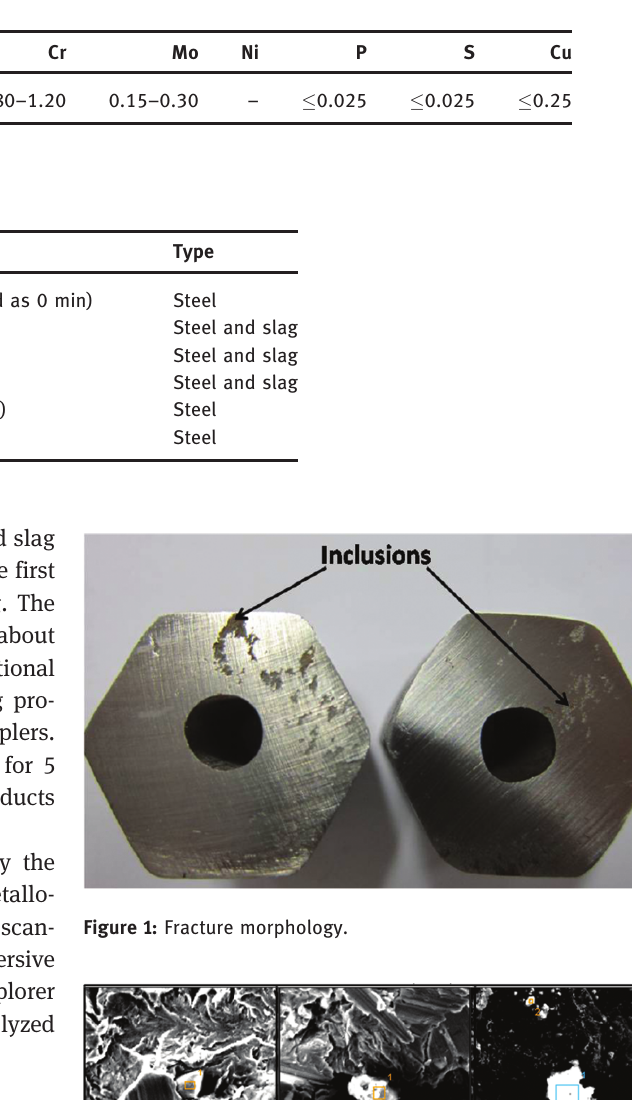
Table 1: Chemical composition of 95CrMo (mass %).